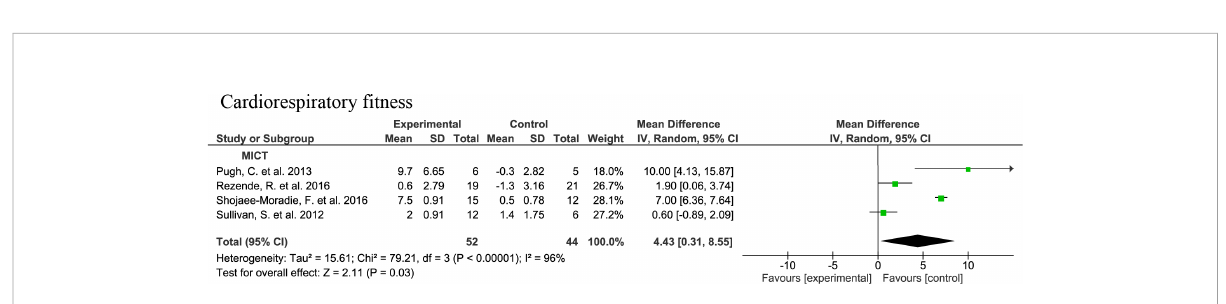
FIGURE 6 Forrest plot for the effect of moderate-intensity continuous training (MICT) on cardiorespiratory fi tness level assessed as maximum or peak oxygen uptake (VO2max or